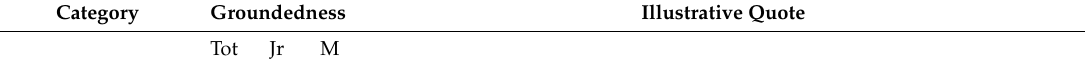
Table 6. Taint normalizing tactics that mitigate the experience of moral taint in consulting.